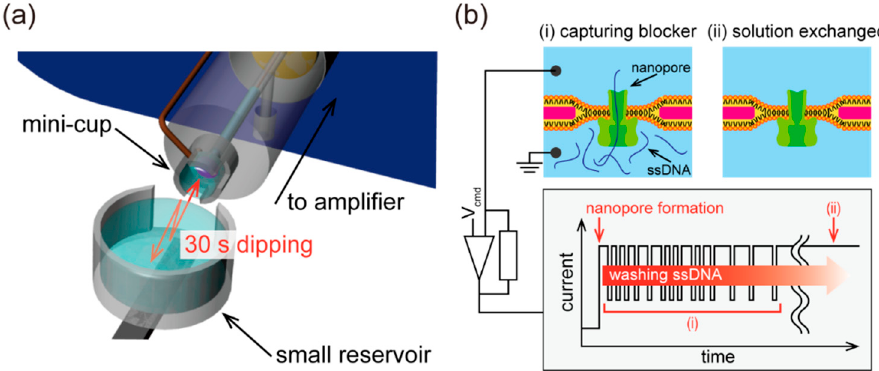
Figure 2. ( a ) Solution exchange procedure. A small reservoir, shown at the bottom, contacts the mini-cup device in a horizontal direction for 30 s, before moving apart. ( b ) Schematic diagram of a time course of an ionic current signal with solution exchange. Blocking events of a nanopore are observed with the existence of single-stranded DNA (ssDNA) (i), while the event frequency decreases with washing by solution exchange (ii).